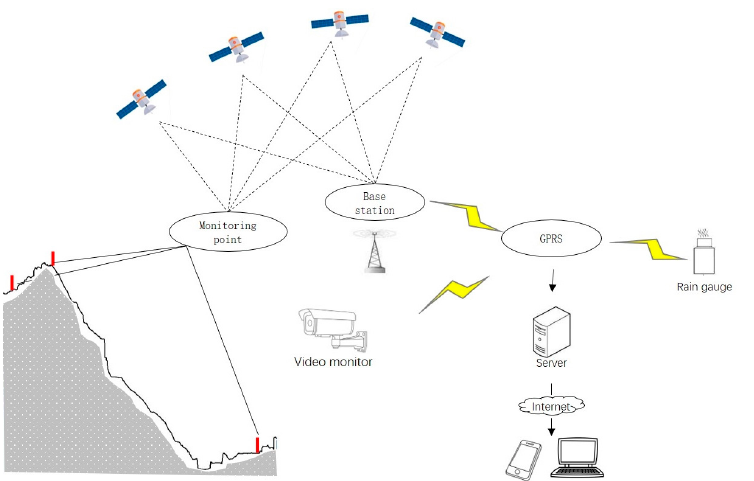
Figure 2. GNSS real-time monitoring system for the Luhu village slope.